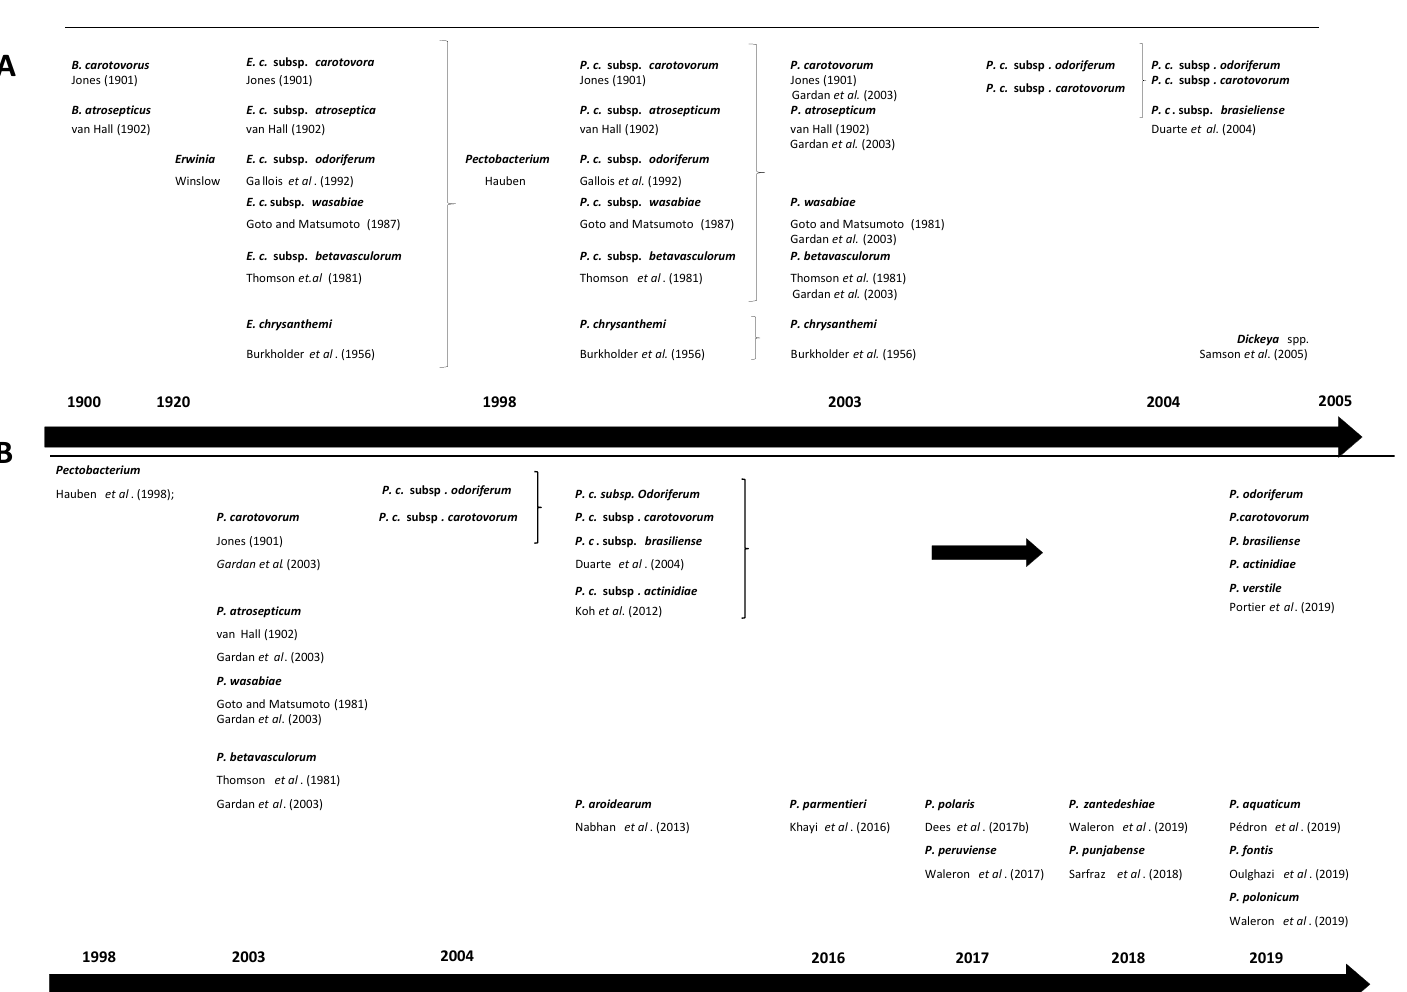
Figure 1. Timeline changes in taxonomy of Pectobacterium spp. ( A ) changes from early described species causing soft rot symptoms Bacillus carotovorus and Bacillus atrosepticus , through establishment of Erwinia species by Winslow et al. up to re-classification of Pectobacterium and Dickeya spp. by Samson et al. [11,33,40,46,47,51–55] ( B ) changes from re-classification of Pectobacterium spp. up to most recent proposed species [11,33,34,38,46,47,51,52,55].